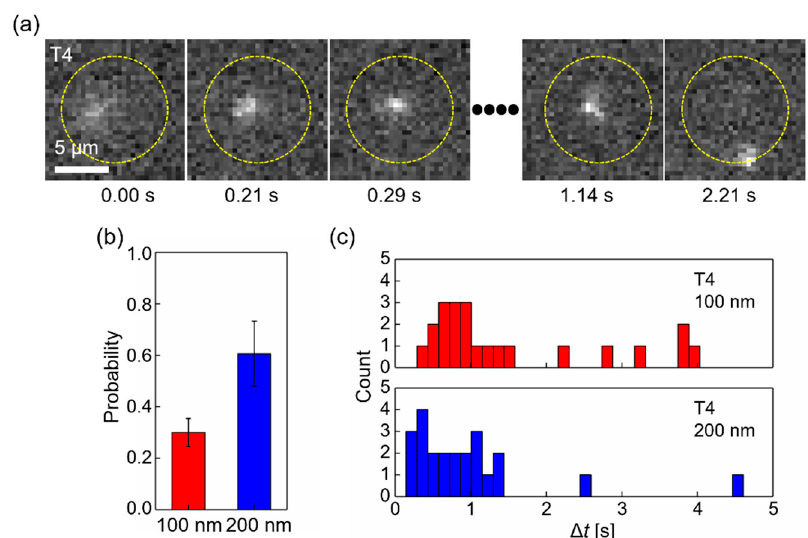
Figure 2. Release of T4 DNA to the cis side after clogging a pore. ( a ) Time-resolved fluorescence images of T4 DNA molecules near a nanopore. Scale bar is 5 µ m. Images were extracted at t = 0.00, 0.21, 0.29, 1.14, and 2.21 s from a sequence of 21 frames recorded at 14 Hz. A DNA approaches a nanopore located at the center in each image marked by a yellow circle. The DNA enters the pore at t = 0.29 s, stays clogged at t = 1.14 s, and then leaves the pore to the cis side. While the DNA clogs the pore, it appears to be stretched out toward the cis side at t = 1.14 s. An external bias voltage of 0.3 V was applied to force the DNA to translocate towards the trans side during observation (see also Video S1 Releases of T4 DNA). ( b ) Probability of such releasing events after clogging in 100 and 200 nm diameter pores. ( c ) Life-time of clogging for released T4 DNA in 100 and 200 nm diameter pores. The bin size is 0.14 s (2 frames).